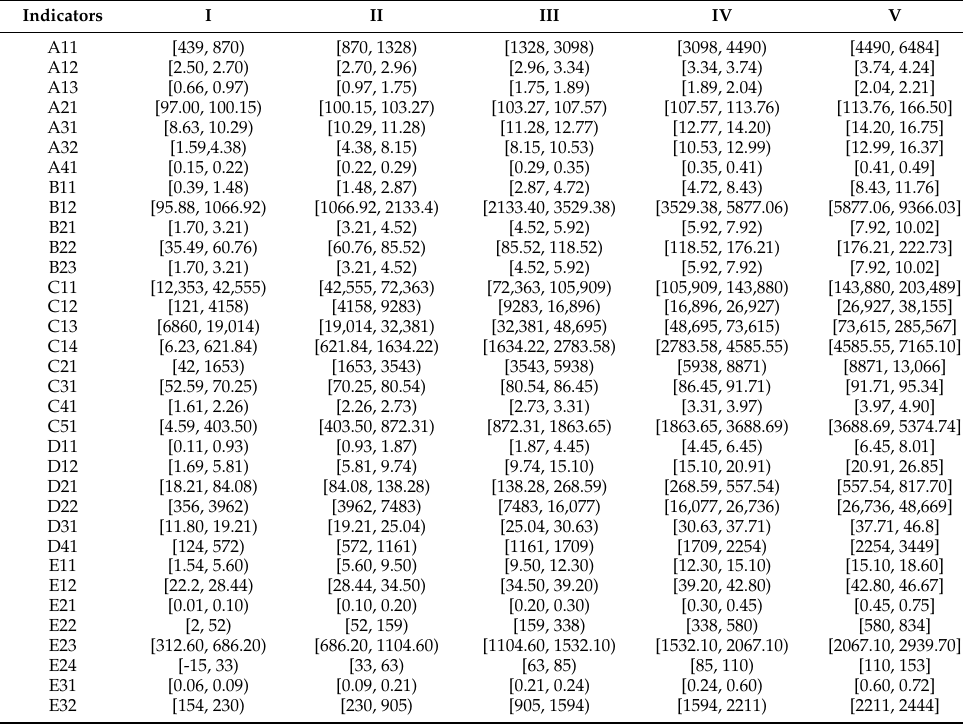
Table 2. CMDRI grading